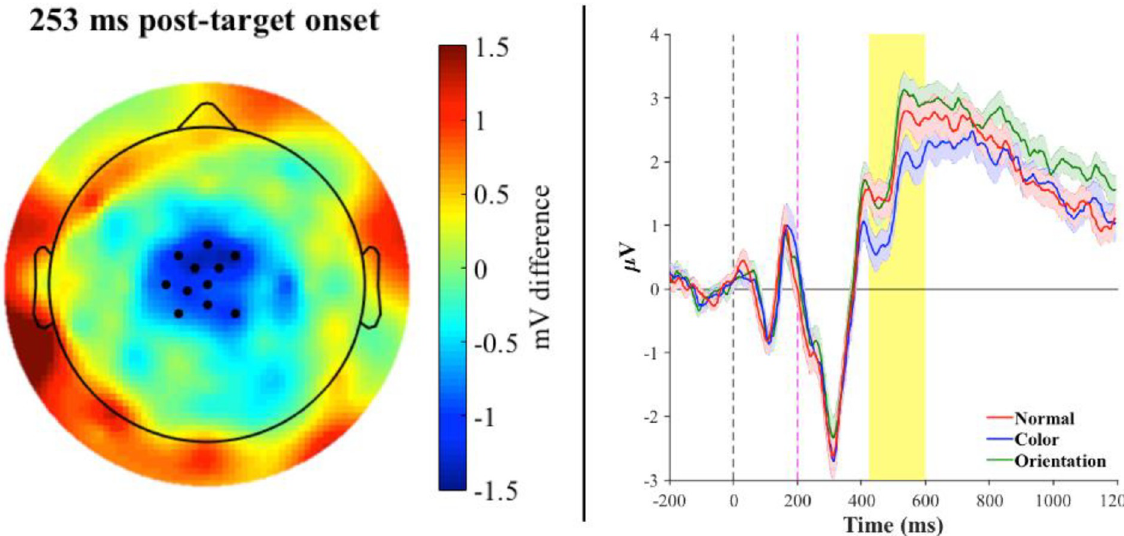
Fig 2. Left panel : Topographic map of the brain at peak channel significance (~253 ms post-target onset) for Color—Normal trials of the natural category . Topography reflects the difference between the grand average for Color—Normal trials, black dots represent the 11 unique significant electrodes at p < 0.009. Right panel : Mean waveforms across the 11-electrode cluster plotted separately for the normal (red), color (blue), and orientation (green) conditions. Significance reflects the difference between the color and normal condition (orientation is also plotted for visualization of the pattern of effect). Shaded regions along the waveforms indicate standard error of the mean. The shaded yellow bar denotes significant time points within the N400 time window. The color condition, compared to the normal condition, elicited the canonical N400. Note: The shaded yellow bar begins at 450ms (corresponding to 250ms post-target onset) due to the 0 time point on the x-axis being locked to the prime onset.